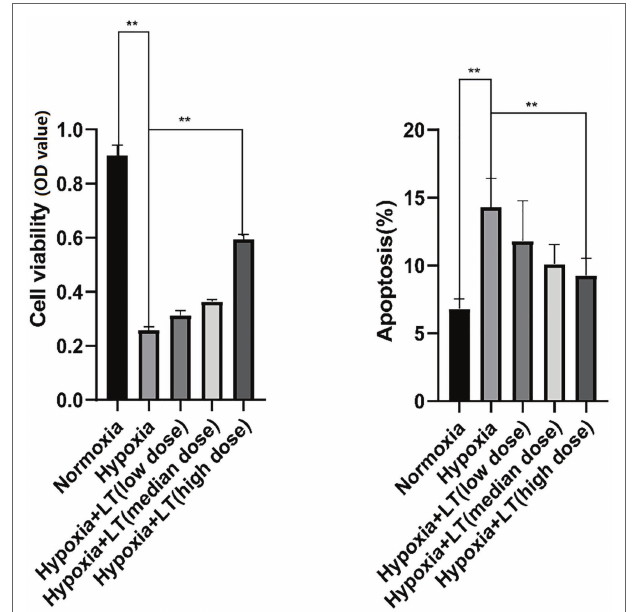
FIGURE 1 | Effects of l -carnitine combined with trimetazidine on cardiomyocytes cultured by hypoxia. Cells were pretreated with or without l -carnitine and trimetazidine (LT), and then cultured in a hypoxic condition. Cells constantly cultured in a hypoxic condition were considered as the hypoxia group. Cells constantly cultured in a normoxic condition were considered as the normoxia group. Cell viability was determined using CCK-8 assay. Cell apoptosis was detected using an Annexin V-FITC apoptosis detection kit. ** p <